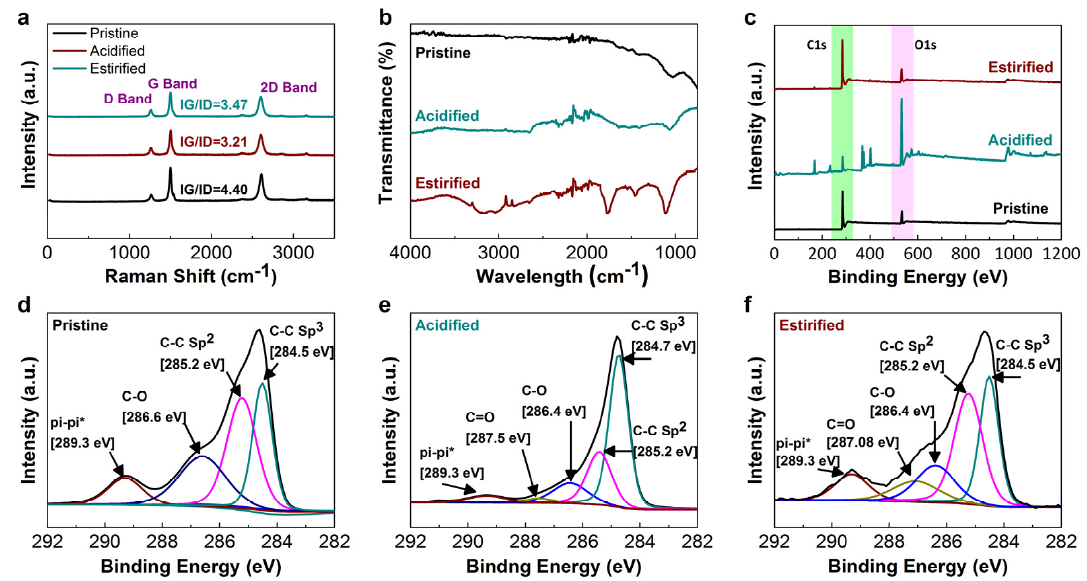
Figure 3. ( a ) Raman Spectroscopy of the D- and G-bands of pristine, acidified, and esterified CNT yarns; ( b ) FTIR of untreated and treated CNT yarns; ( c ) XPS analysis reveals a peak corresponding to C1s at 284.5 eV, N1s at 401.1, and O1s at 532.1 eV. C1s; and XPS spectra for ( d ) pristine, ( e ) acidified, and ( f ) esterified CNT yarns.